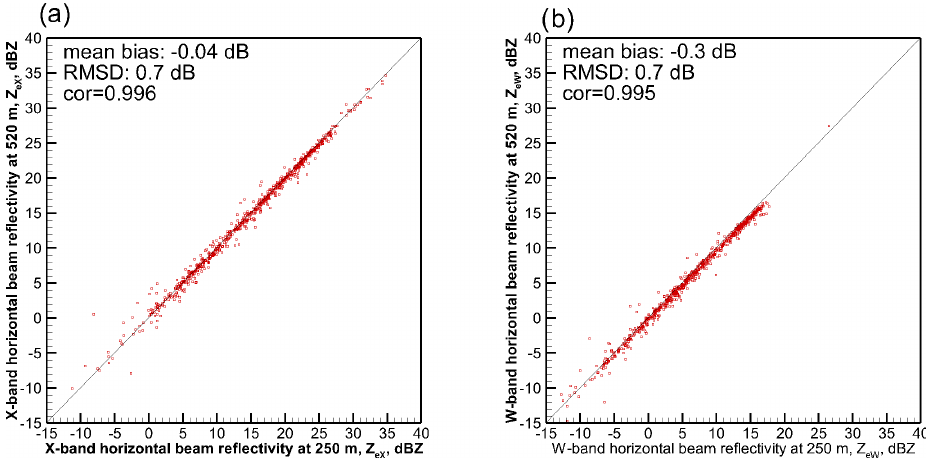
Figure 1. Scatter plots of observed reflectivities at 250 and 520m distances for (a) X-band and (b) W-band horizontal beam